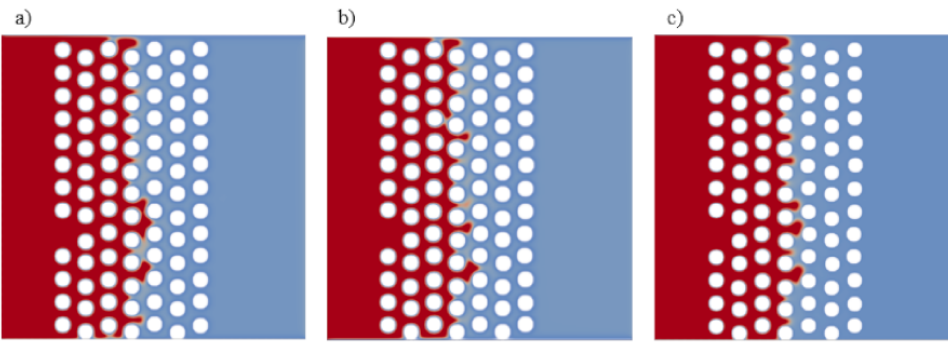
Figure 9. Gaseous phase penetration for circular pores at t ∗ = 0.275, C a = 0.038, at: ( a ) D = 1; ( b ) D = 2; ( c ) D = 3.